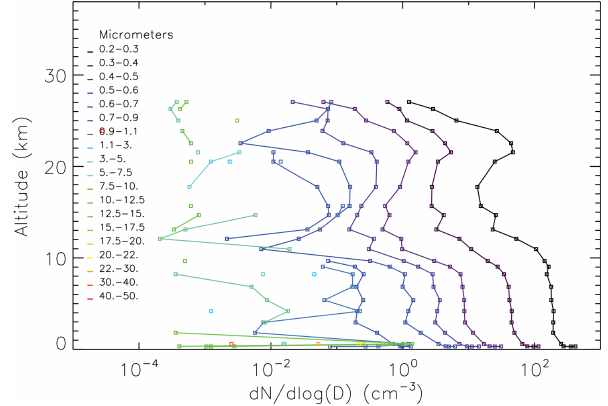
Figure 3. Vertical profiles of particle size distributions for the 19 size classes of the LOAC particle counter as part of the A5- Unibo experiment on the BEXUS18 stratospheric flight. The no- tation d N /dlog( D ) used in the x axis stands for the number concen- tration of particles in the various size classes divided by the width of the size